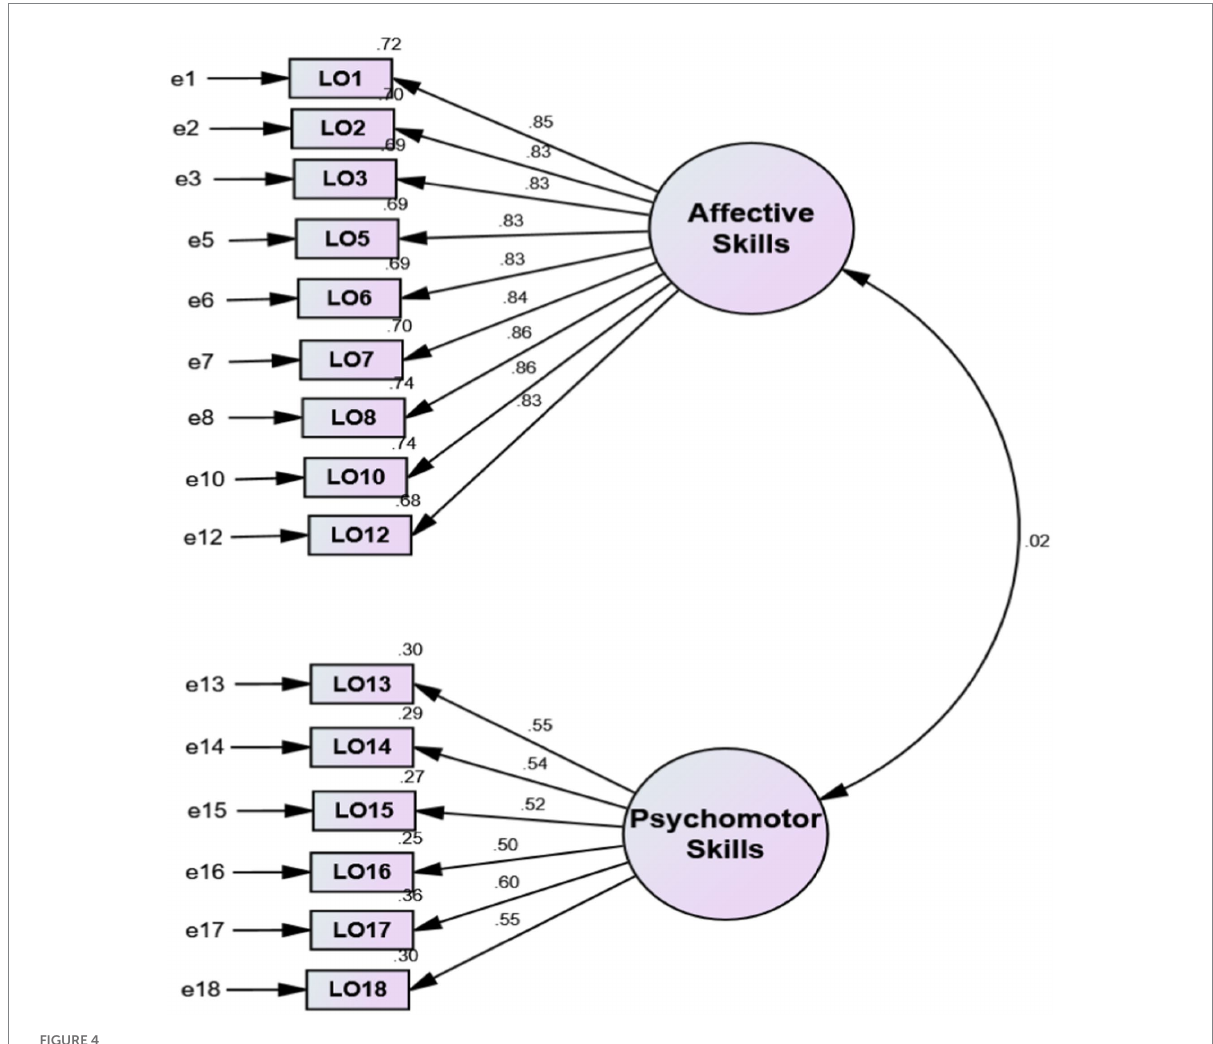
FIGURE 4 Standardized latent-trait CFA model of the